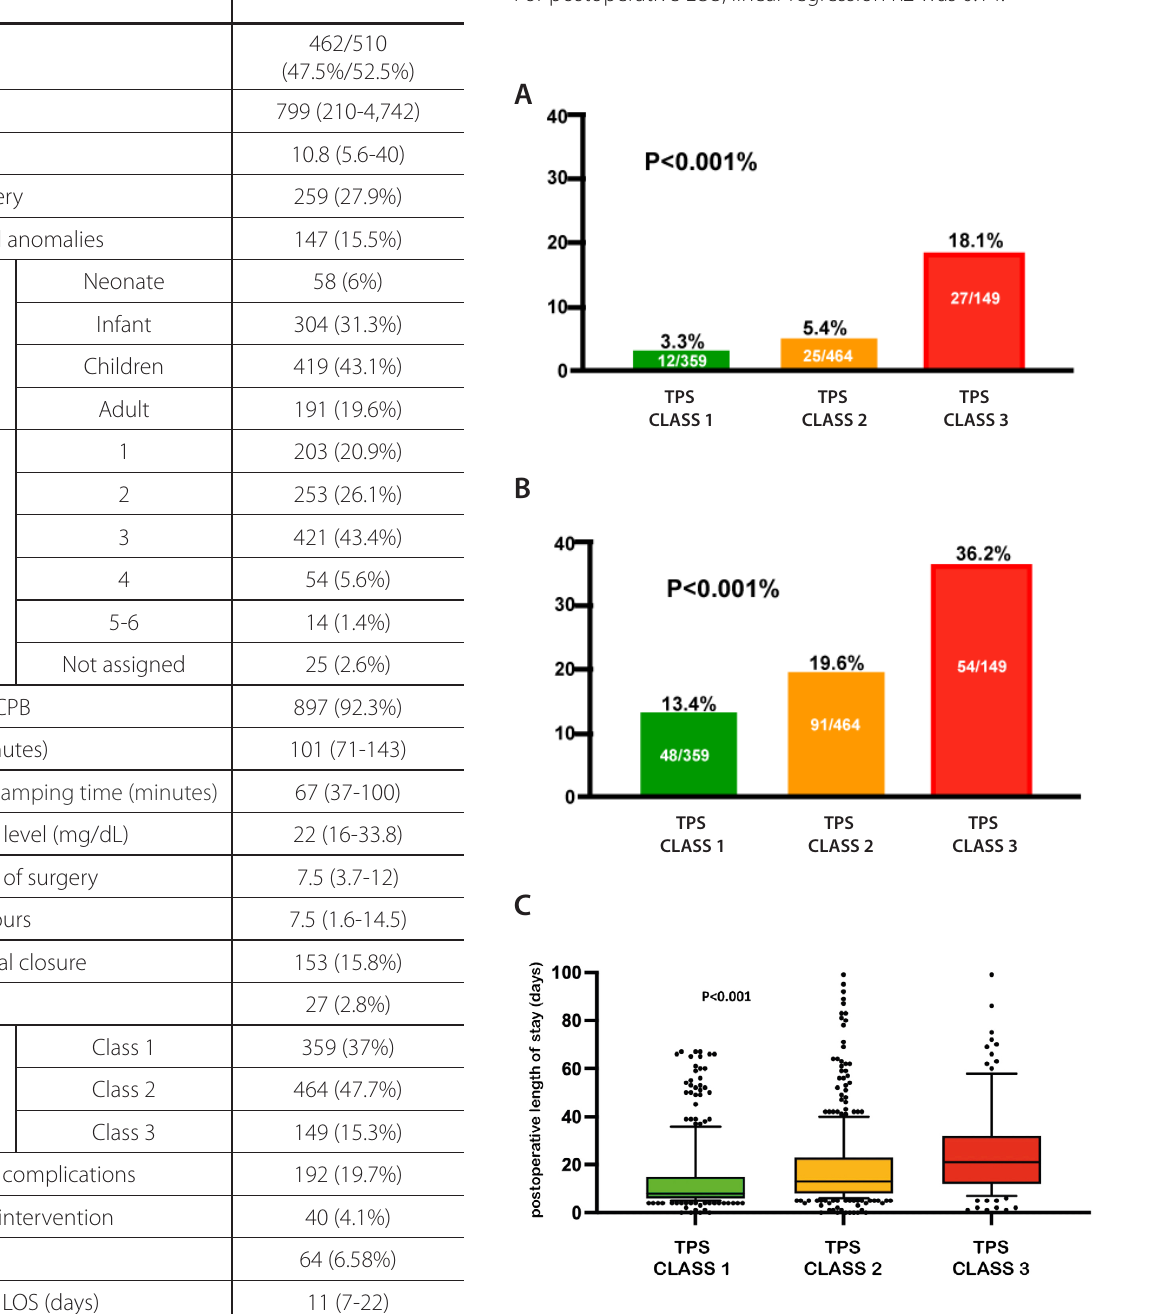
Fig. 1 - Outcomes measured by the Technical Performance Score (TPS). A) Global mortality according to the surgical result measured by TPS. B) Complications according to the surgical result measured by TPS. C) Graph of dispersion of the postoperative length of stay according to the surgical performance calculated by TPS.